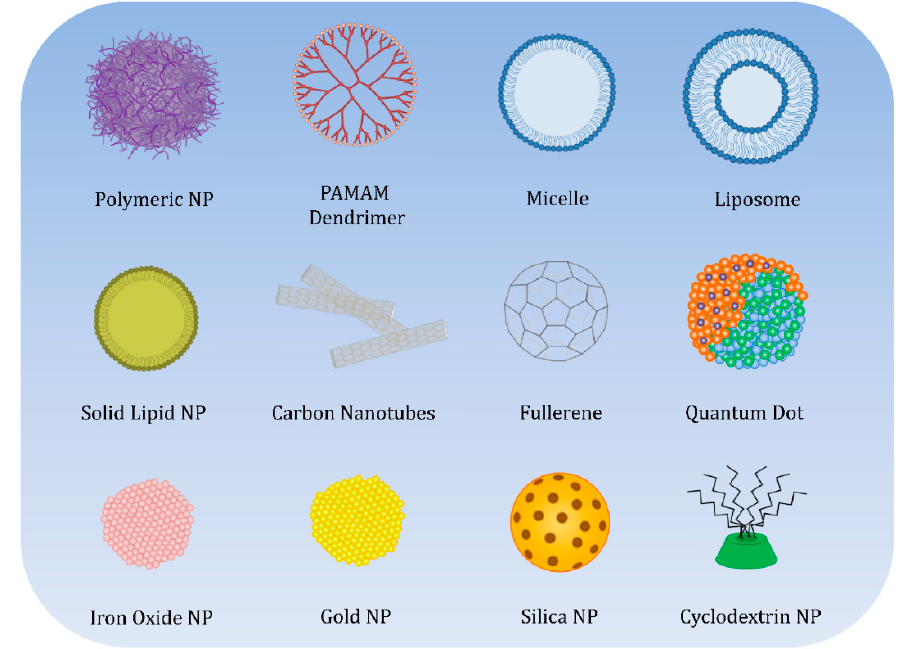
Figure 3. Representation of the different kinds of NPs included in this review. Albumin-Based